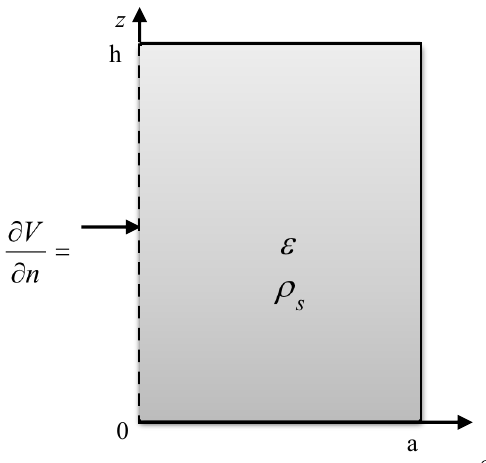
Figure 2. Axisymmetric Homogeneous Domain Approximation of a cylindrical tank of radius a and height h .